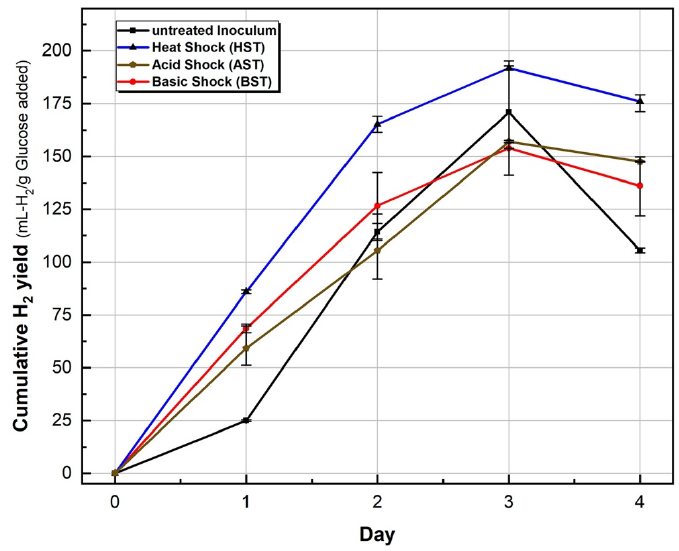
Figure 4. Cumulative hydrogen production for untreated and treated inoculum during 5-day BHP tests (average value of triplicate with max/min bar). Table 2. Biogas composition of the maximum biogas volume produced during 5-day BHP